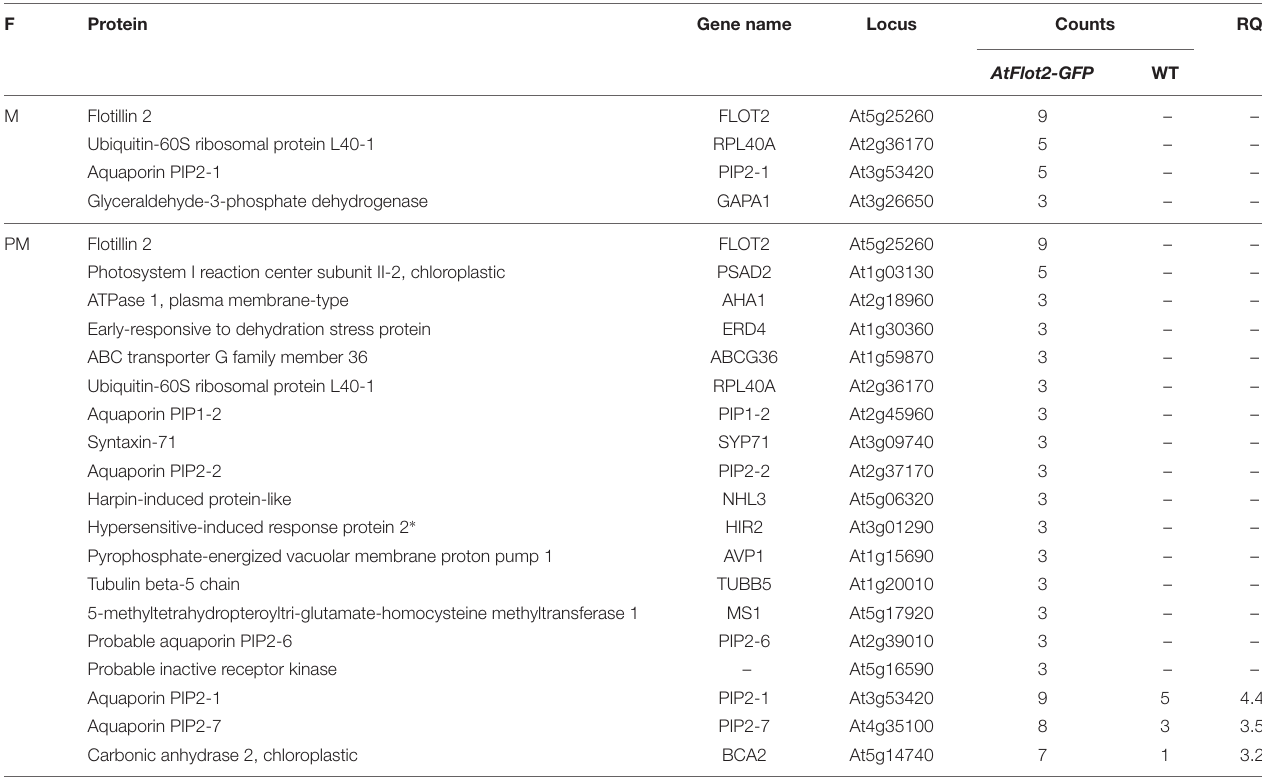
TABLE 1 | Potential interactors of Arabidopsis flotillin